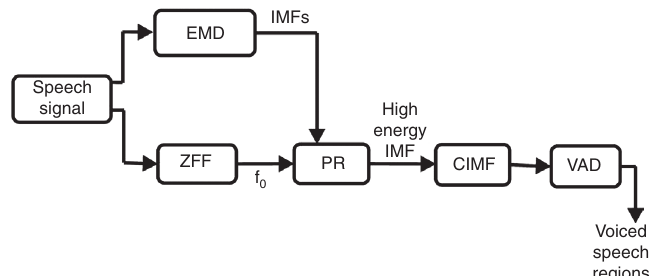
Figure 3. Block Diagram of a VAD Algorithm Using ZFFPR and EMD.